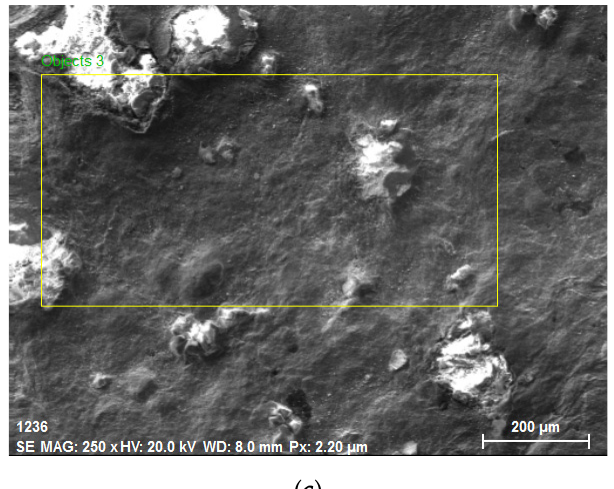
Table 2. Lattice parameters and DB card numbers of the phases.